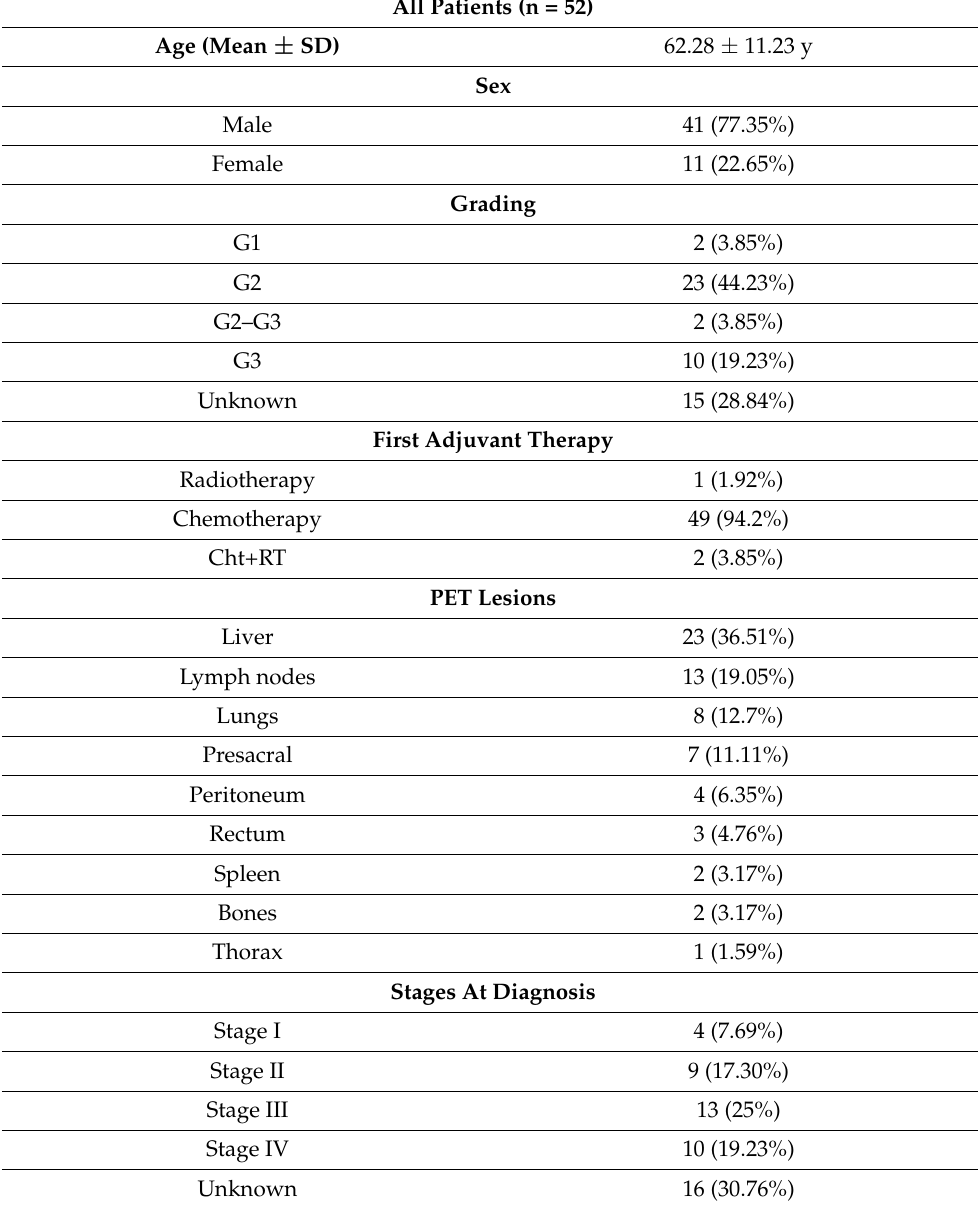
Table 1. Patients’ main